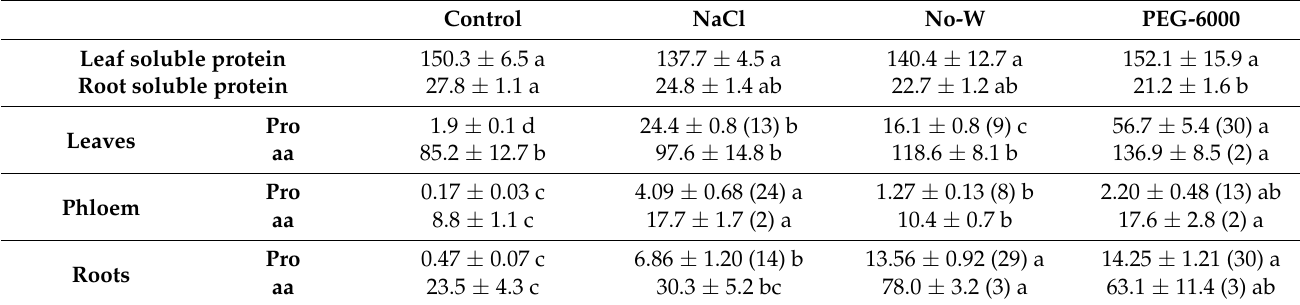
Table 3. Effect of the different water-stress treatments on the soluble protein and amino acid content.